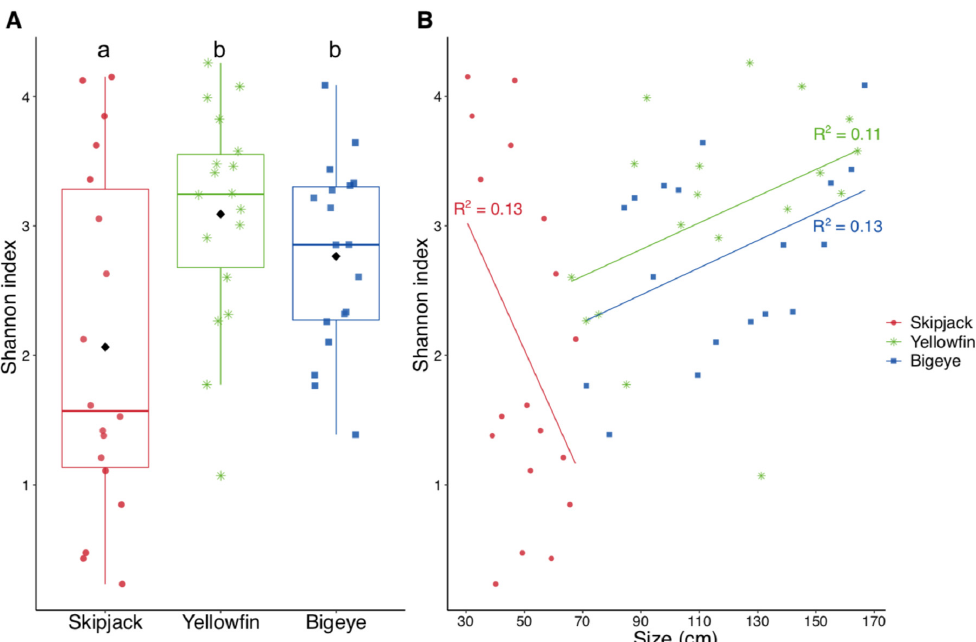
Figure 2. Representation of alpha taxonomic diversity (Shannon index) of enteric bacterial communities (ASVs) in the three tuna species ( A ), and according to the size of individuals ( B ). Boxplots represent the distribution of the alpha taxonomic diversity within each species. Different letters indicate significant differences (KW, p < 0.05) between groups within each square. * Significant correlation between the Shannon index and fish size (Pearson, p < 0.05).